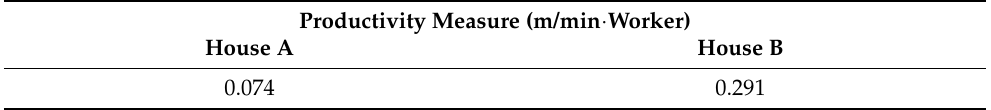
Table 7. Productivity rate for the assembly of House A and House